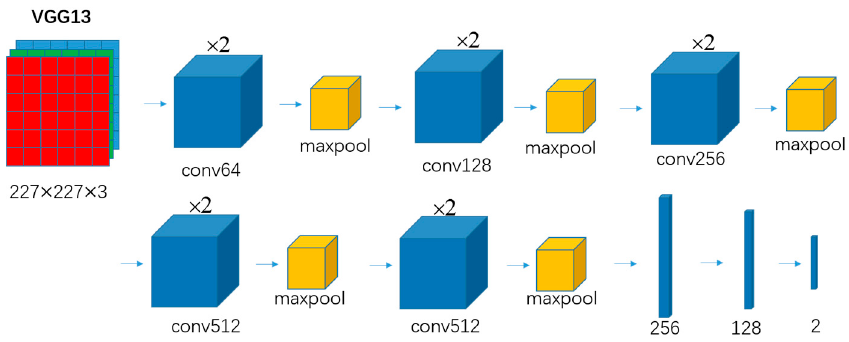
Figure 4. VGGNet13 model.